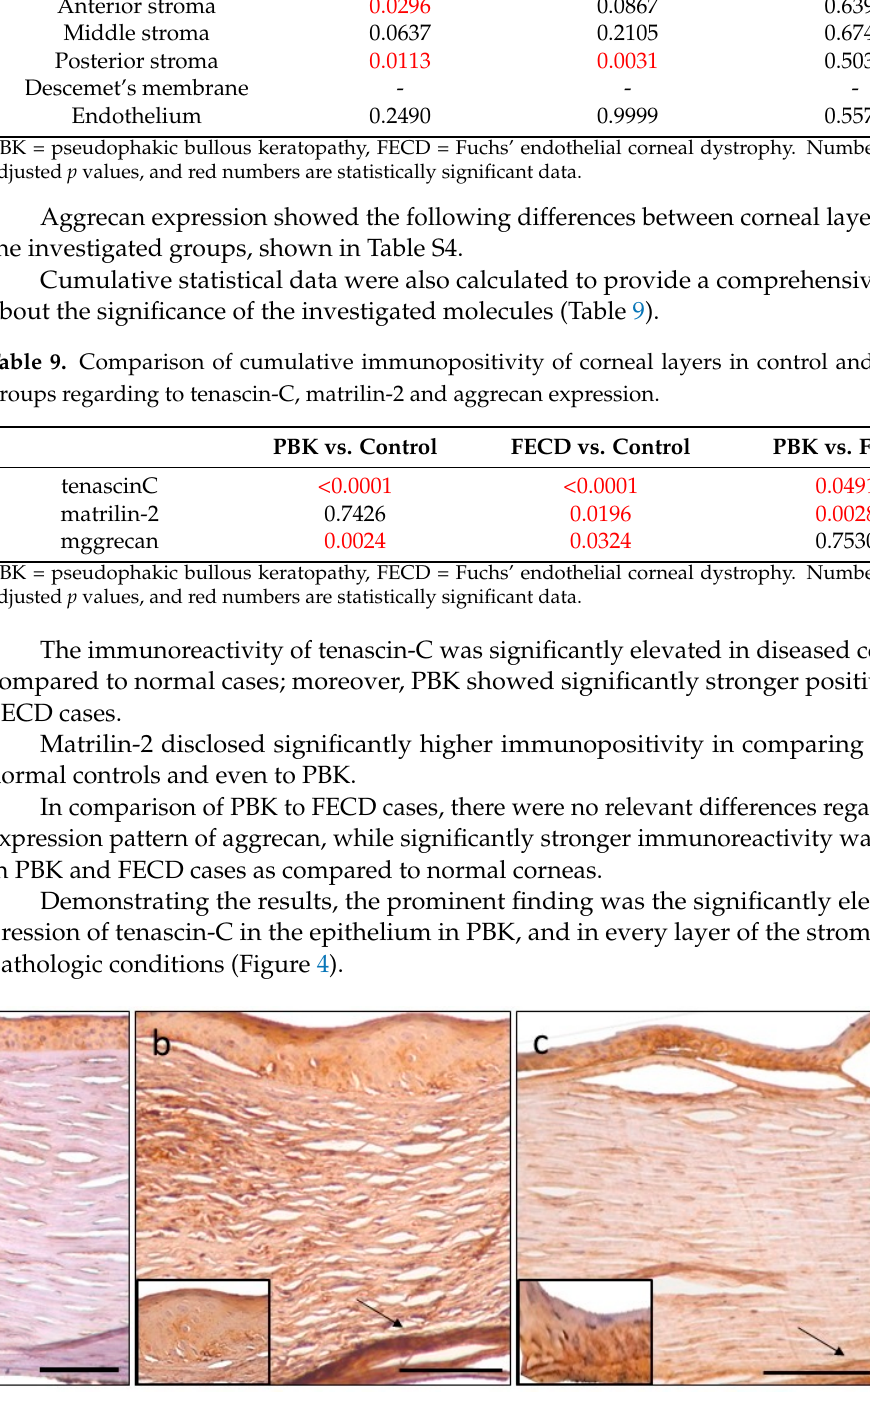
Figure 4. Tenascin-C immunohistochemistry. Control cornea with moderate positivity in the epithelium ( a ). Intense expression in PBK in the epithelium and throughout the stroma, most prominent in the pre-Descemet area (arrow) ( b ). Moderate epithelial and mild stromal staining in FECD, stromal distribution pattern is similar to PBK, with prominent posterior stromal labelling (arrow) ( c ). Epithelial signal intensity (insets). Scale bar indicates 100 µm.